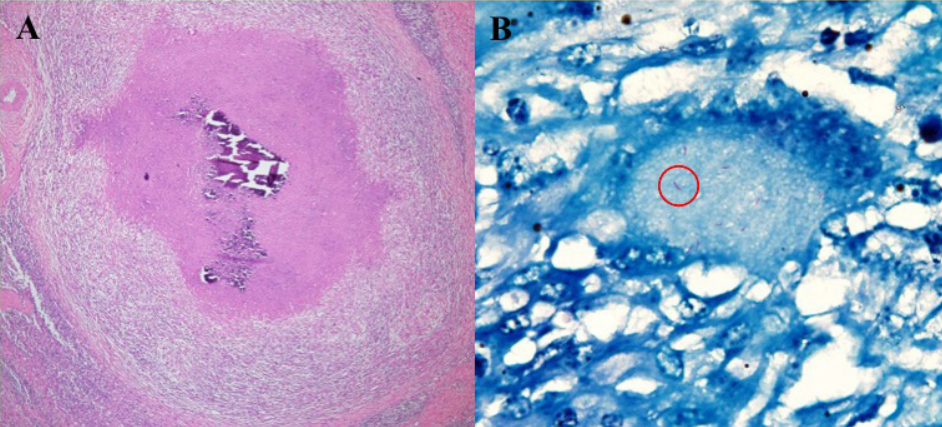
Figure 2. Lesions suggestive of bovine tuberculosis, obtained in slaughterhouses, under SIF, during post-mortem inspection. (A) Characteristic granuloma of tuberculosis, presence of central area with dystrophic calcification, subsequent necrosis, surrounded by inflammatory infiltrate composed mainly of macrophages. HE staining, 4x magnification. (B) Cut displaying AFB (circled) in the cytoplasm of a giant Langhans cell. Circle in red showing the colored AFB. ZN stain, increase of